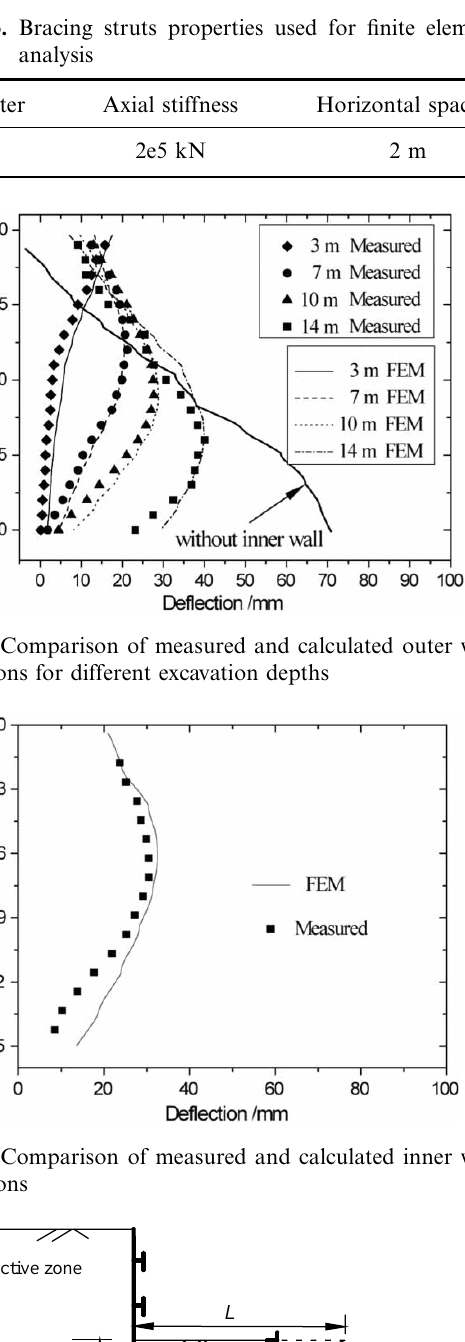
Table 3. Bracing struts properties used for finite element